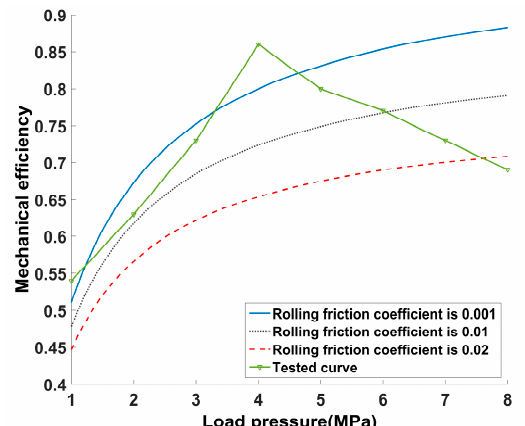
Figure 18. Comparison between the experimental and analytical results at different rolling friction coefficients at 5000 rpm.